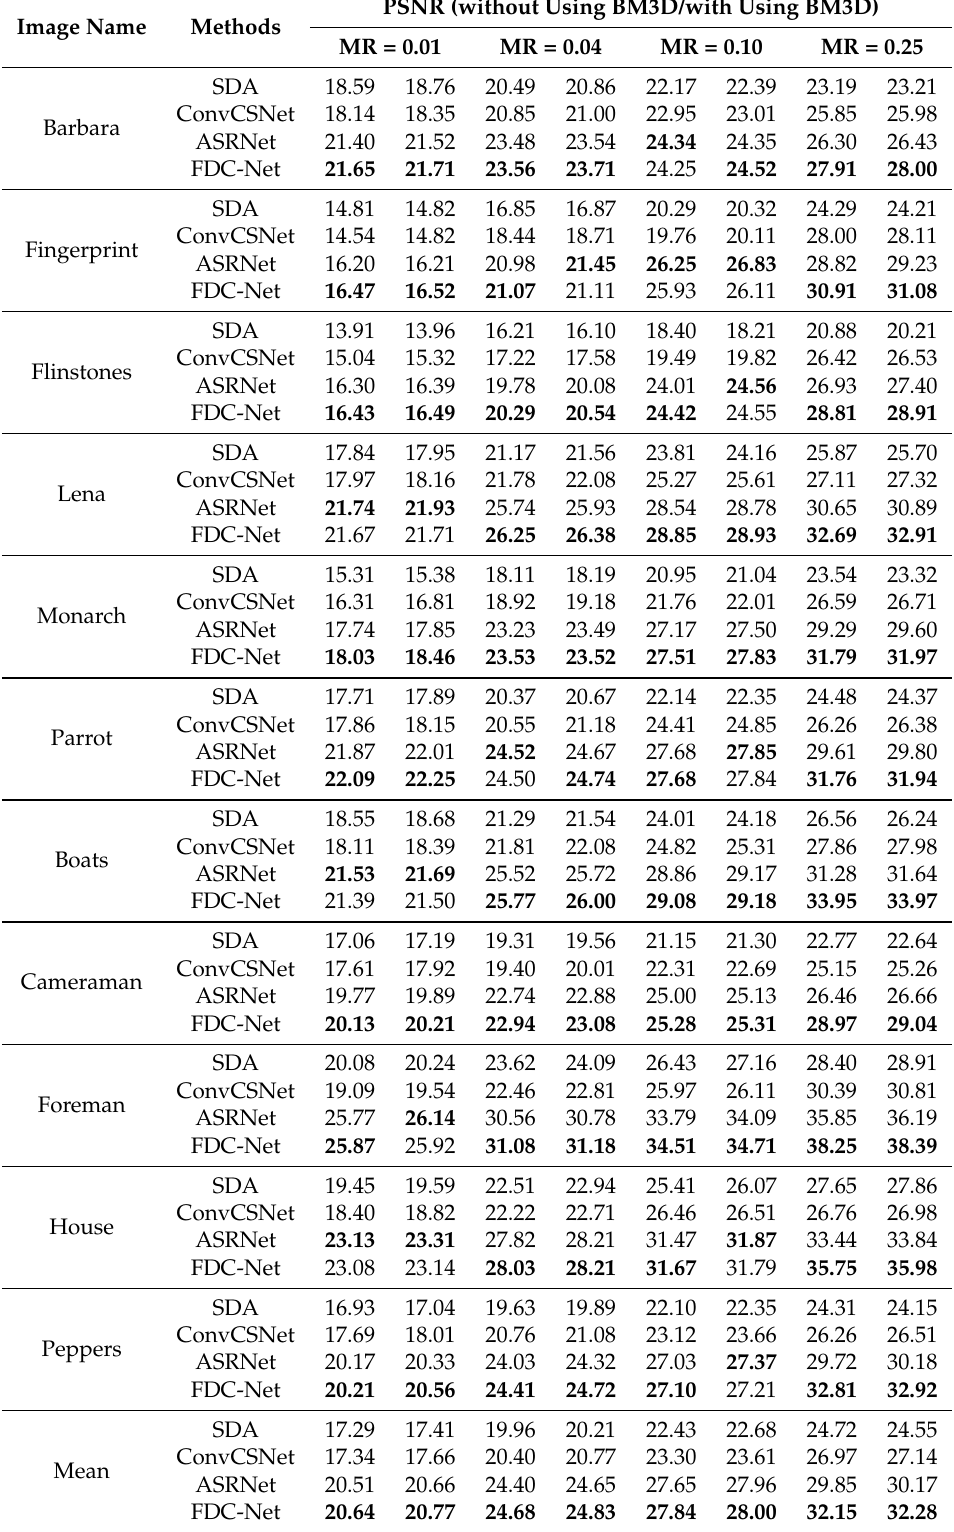
Table 2. Reconstruction results for test images through different algorithms at different measurement rates. “Mean” is the mean value among all test